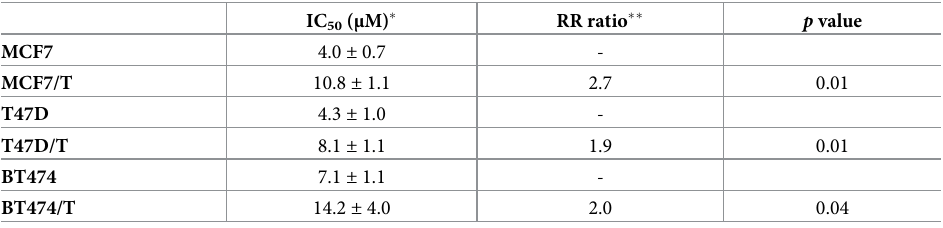
Table 1. IC 50 values for tamoxifen for wild-type and tamoxifen-resistant